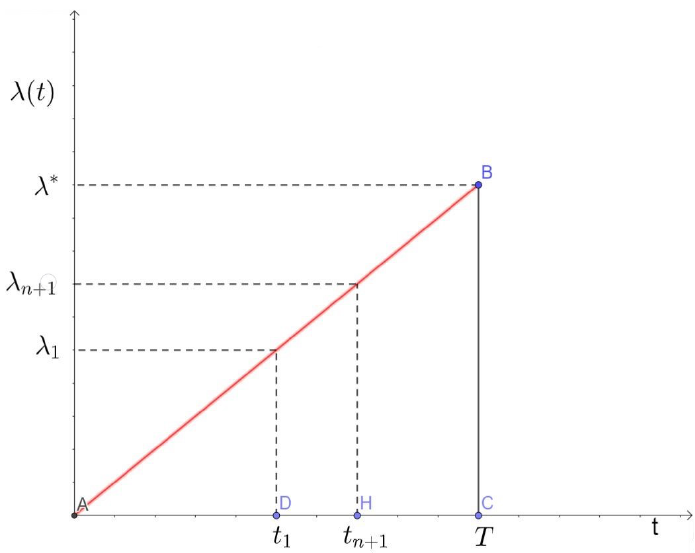
Figure 2. Linearly increased-ramp dynamic load. λ stands for generalised dynamic load (i.e., Force, load factor, applied stress) over time